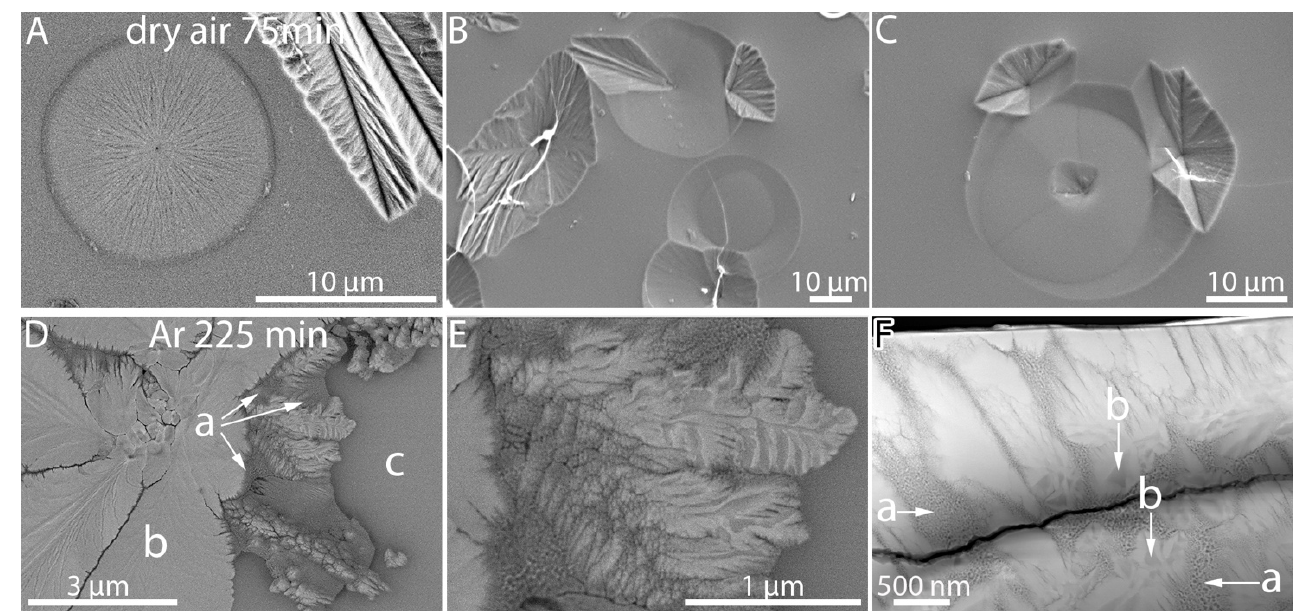
Figure 2. LSM overview images showing that the crystals in Figure 1 are representative.